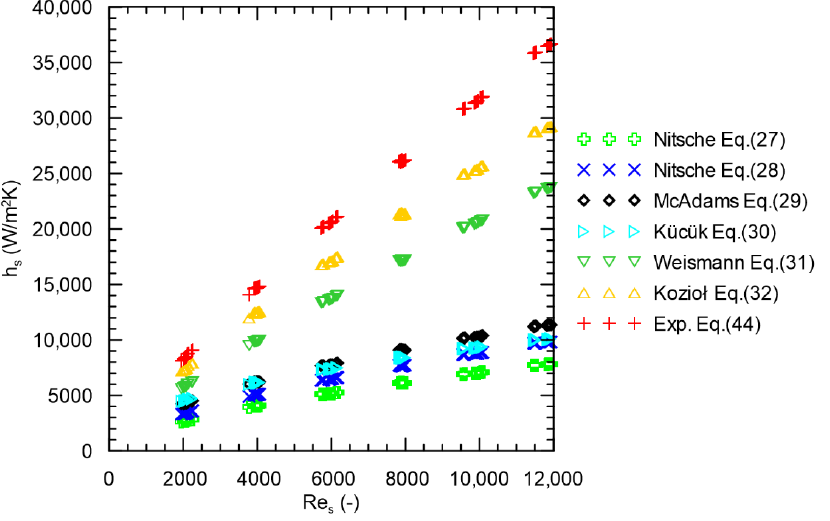
Figure 6. Heat transfer coefficient for the flow at the shell side h s as a function of the Reynolds number Re